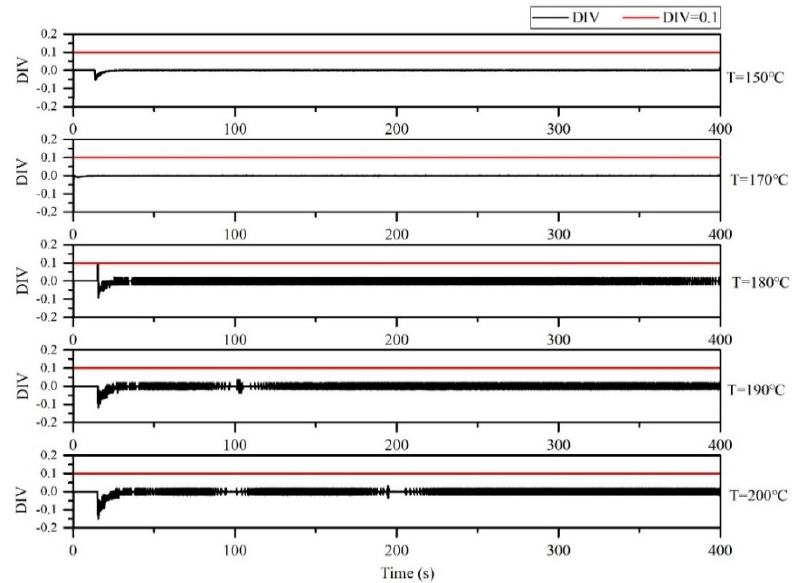
Figure 16. DIV diagram of temperature monitoring in the microreactor at different jacket